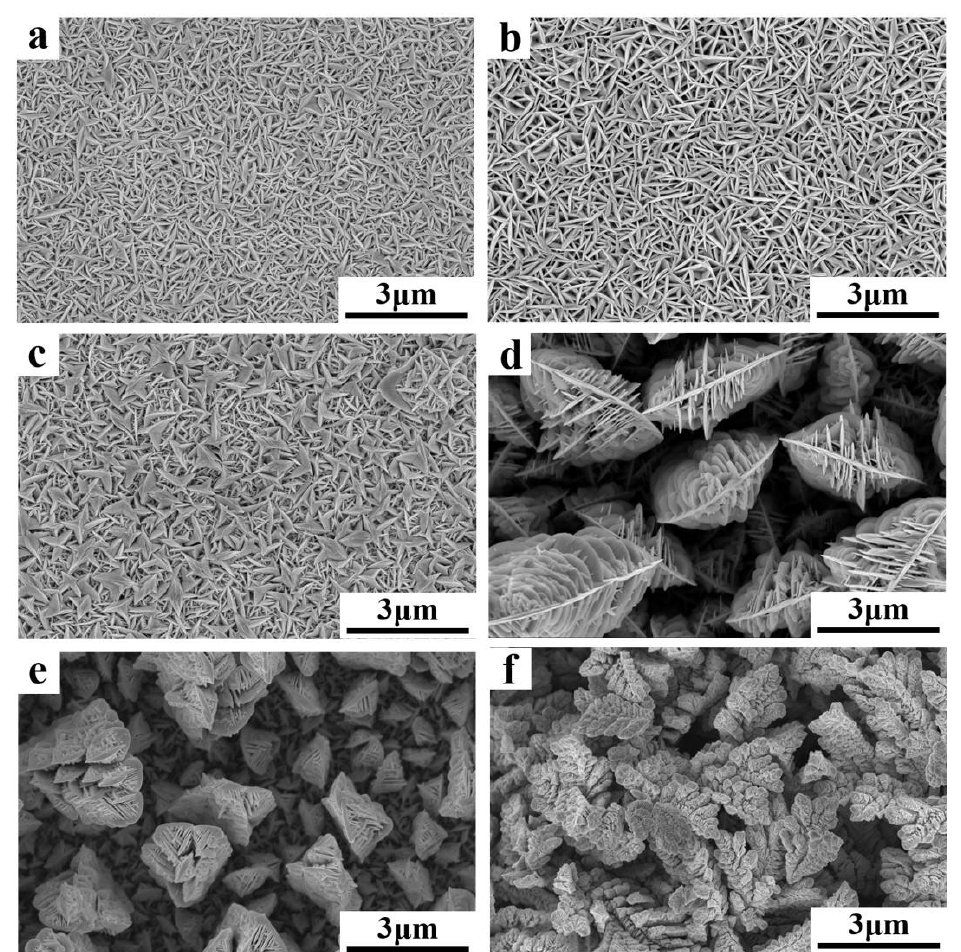
Figure 4. Micro-morphology of the films deposited after 1200 s in the 7.5 mM Bi and 10 mM Te electrolyte at the potential of ( a ) −35 mV, ( b ) −60 mV, ( c ) −80 mV, ( d ) −120 mV, ( e ) −180 mV, and ( f ) −220 mV.